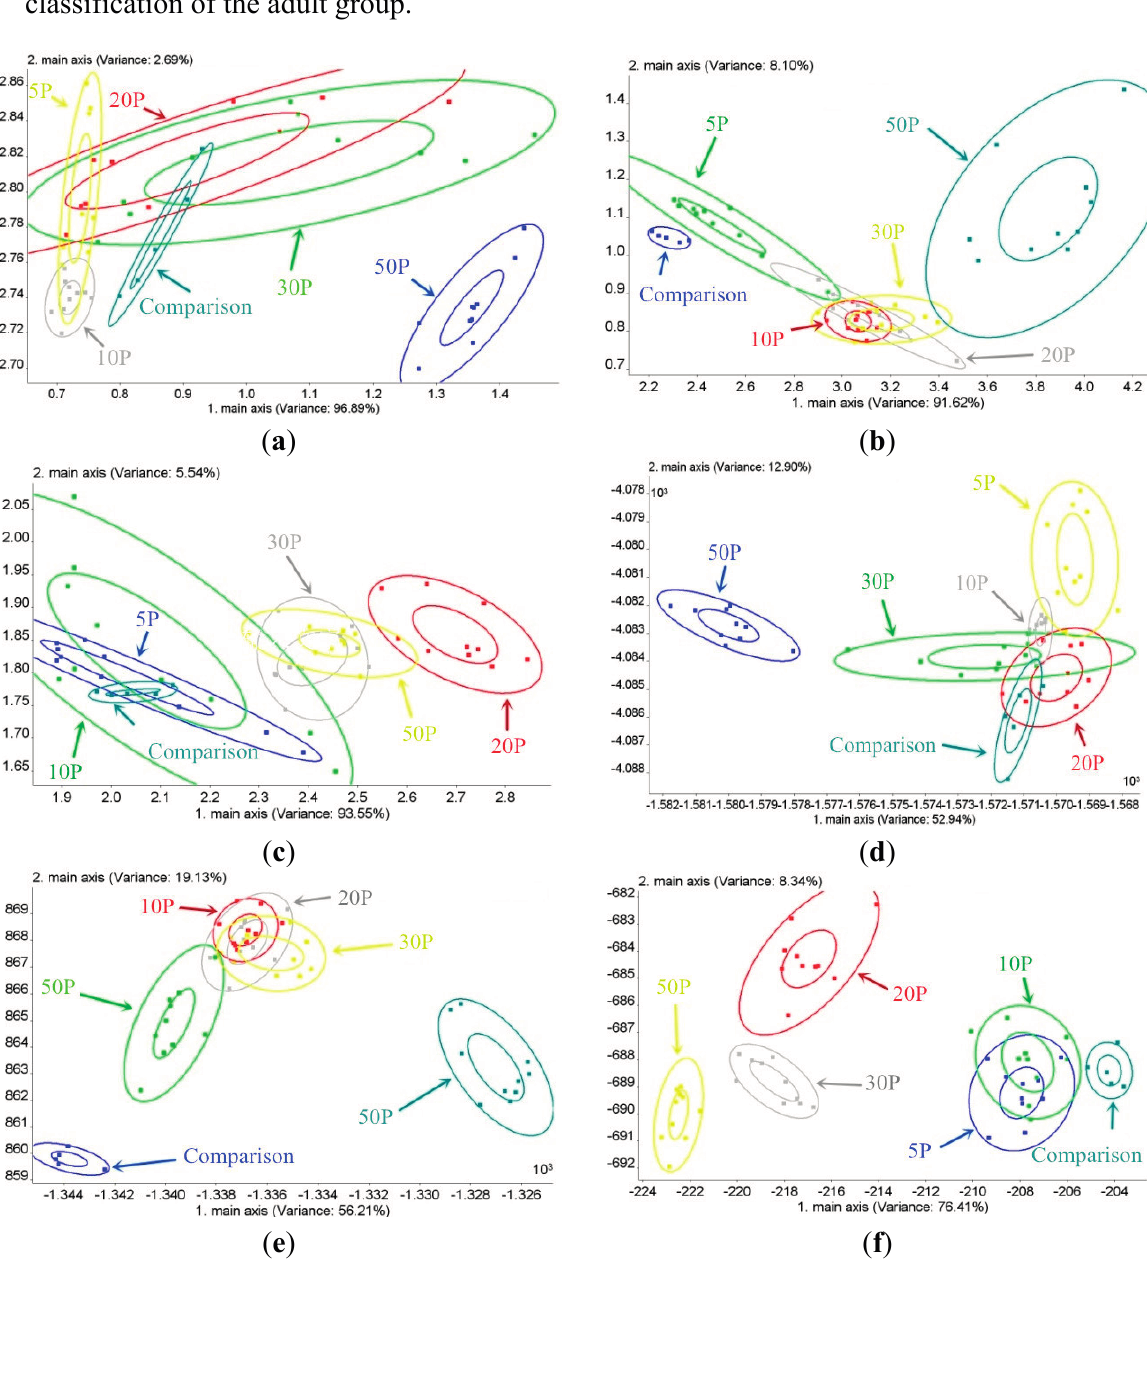
proportion to the cumulative contribution of the LDs. In addition, the LDA classification performance is superior to that of PCA. Figure 5. BRPH amount classification for different ages: ( a ) PCA for the amount classification of the younger than 3rd-instar nymphs (U3IN) group; ( b ) PCA for the amount classification of the older than 3rd-instar nymphs (O3IN) group; ( c ) PCA for the amount classification of the adult group; ( d ) LDA for the amount classification of the U3IN group; ( e ) LDA for the amount classification of the O3IN group; ( f ) LDA for the amount classification of the adult